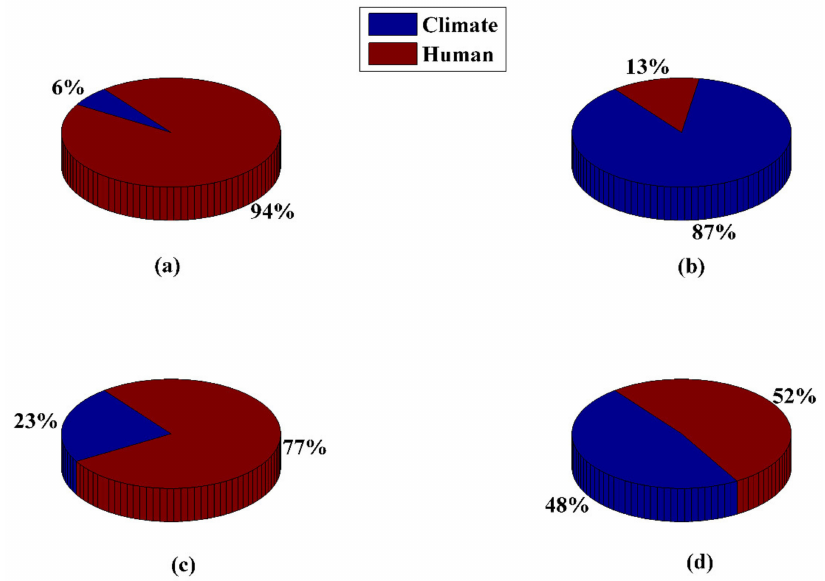
Figure 7. The relative contributions of human activities and climate change for maize yield over different timescales (original ( a ), IMF1 ( b ), IMF3 ( c ), and R ( d